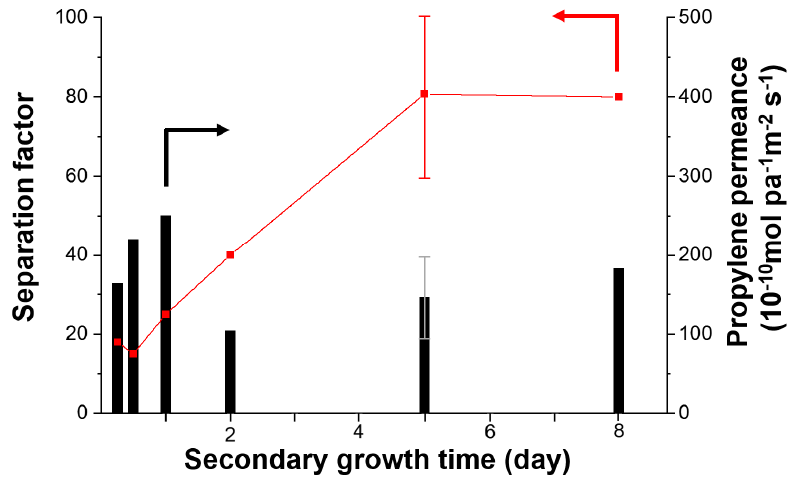
Figure 4. Binary propylene/propane separation factors and propylene permeances of ZIF-8 tubular membranes with increasing secondary growth time. Additional samples (five membranes from three batches) were synthesized to generate the standard error bar.